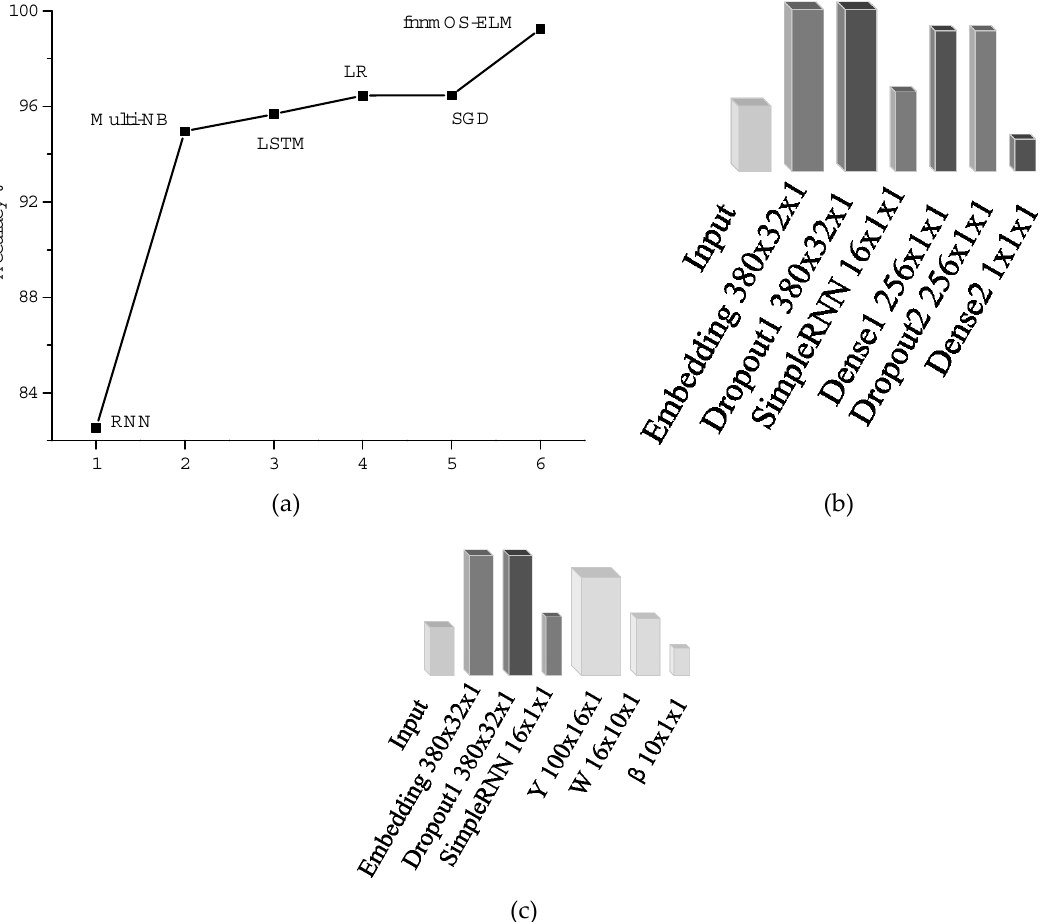
Figure 4. Performance of different methods and network structures. ( a ) Comparison of accuracy. ( b ) Network structure of the recurrent neural network (RNN) model. ( c ) With i = 4, the fnnmOS-ELM model uses the first four layers of the RNN as the feature extraction layers. Table 3. Training time and parameters on the IMDb dataset.